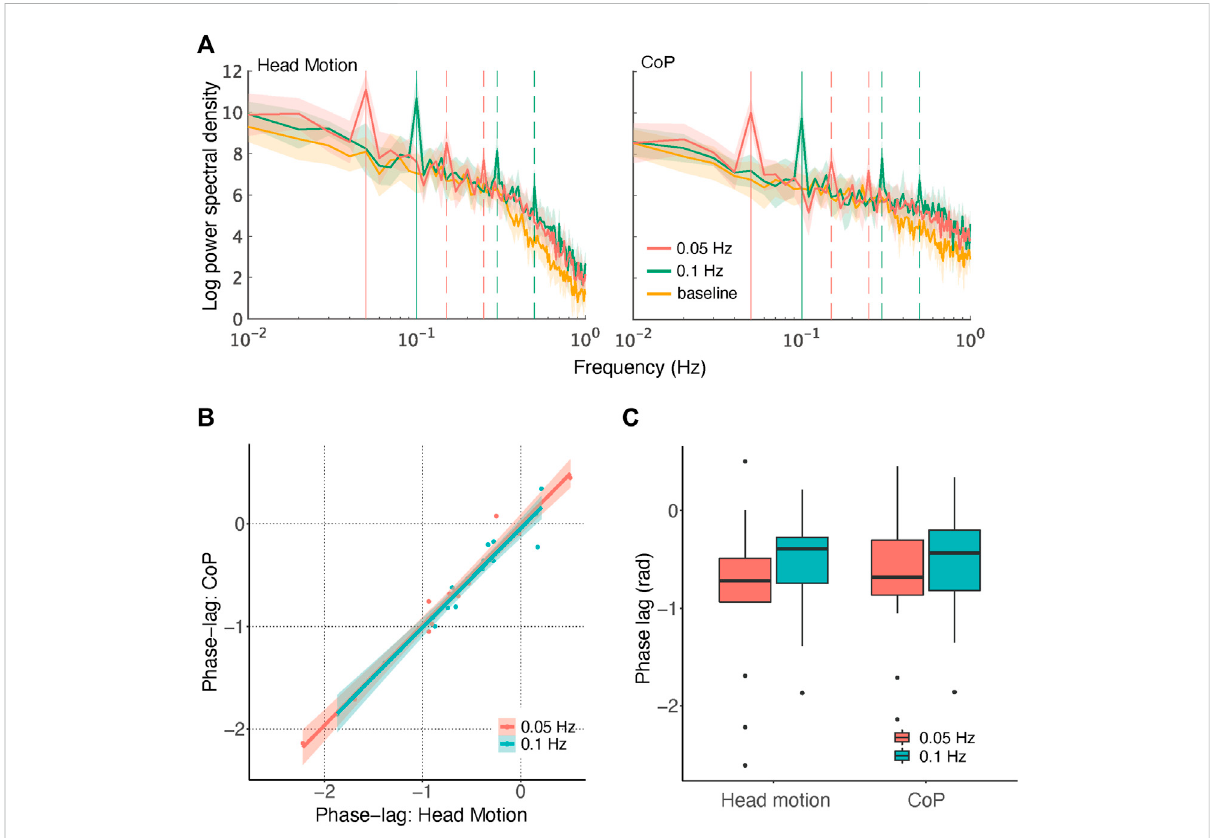
FIGURE 3 Results in the frequency domain. (A) Log-power spectra for each condition with 95% con fi dence intervals. Vertical solid lines depict the frequencies of direction changes, and dashed lines depict their third and fi fth harmonics. (B) Correlation of phase lags between head motion and CoP. Fitted linear functions are shown with 95% con fi dence intervals. (C) Box plot of phase-lag